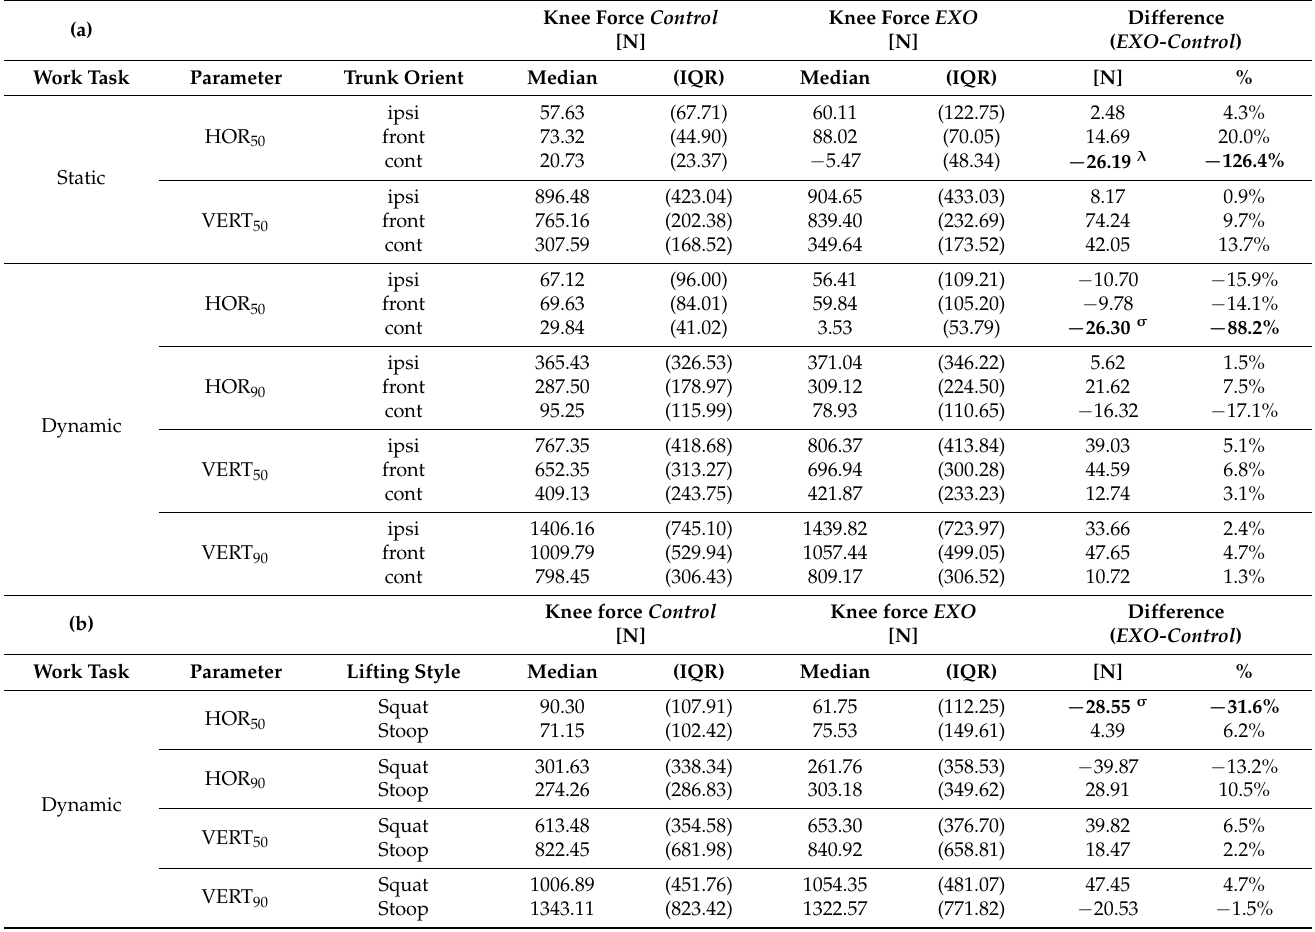
Table 2. Median knee force values and corresponding interquartile ranges (IQR), absolute and relative differences showing EXO compared to Control for static and dynamic work tasks (two-fold interactions ( a ) EXO × Trunk orientation and ( b ) EXO × Lifting style ).